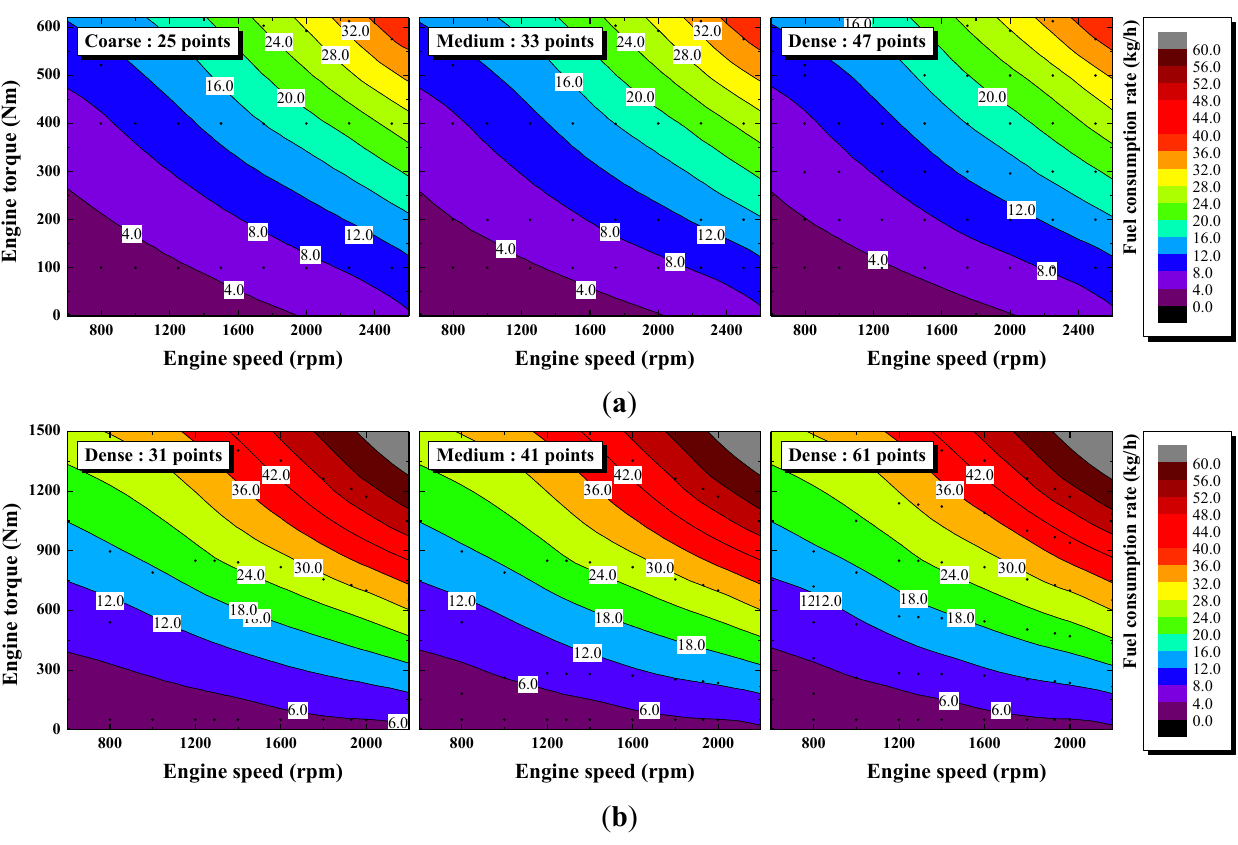
Figure 10. Difference in predicted fuel consumption rate as changes in the reference data points (IDW interpolation method): ( a ) Vehicle A ( b ) Vehicle